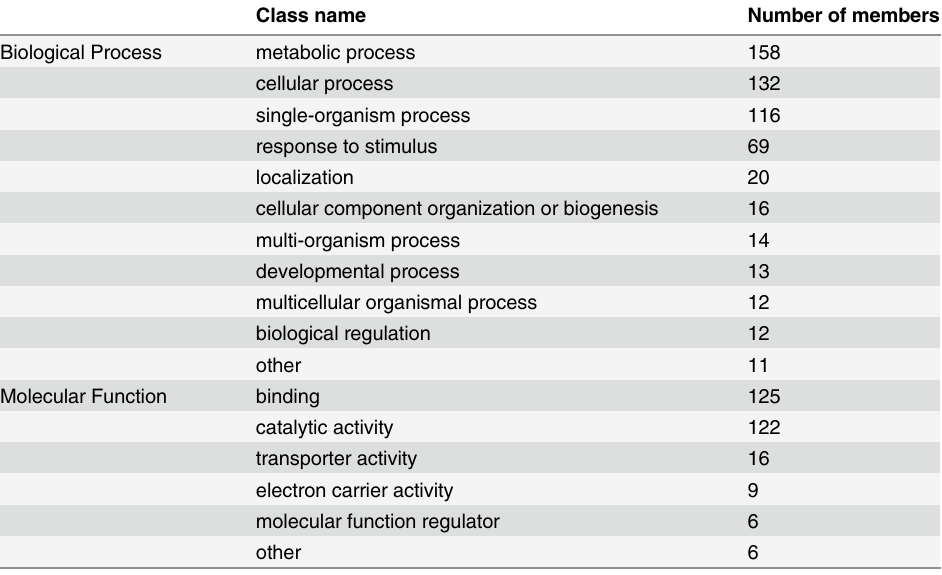
Table 1. GO classification for lysine succinylated